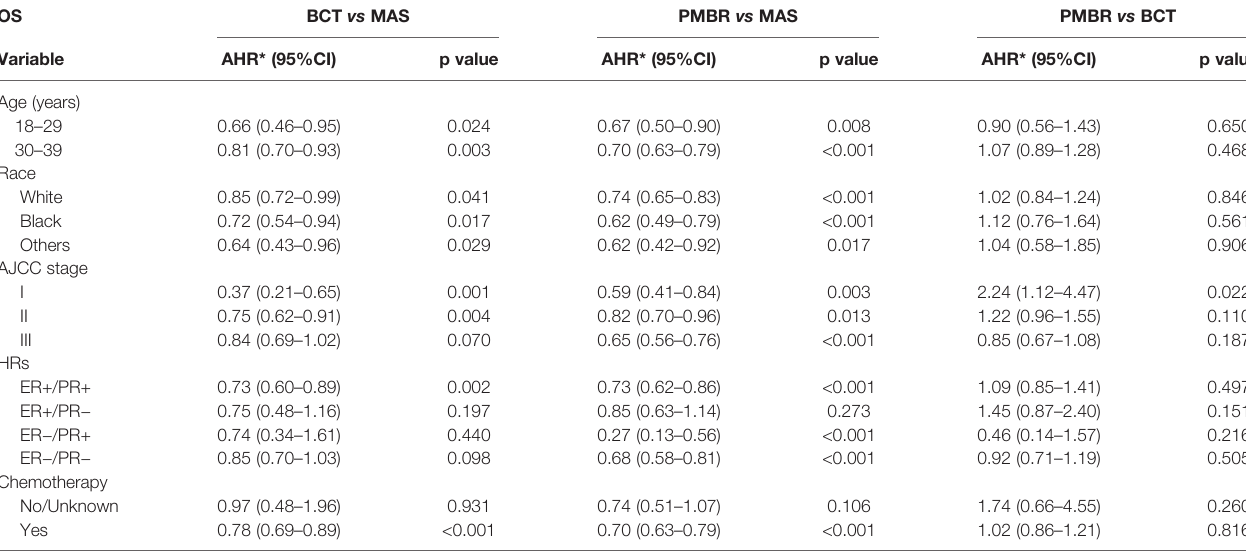
TABLE 2 | Effects of surgery in overall survival by demographic and pathological subgroups. OS BCT vs MAS PMBR vs MAS PMBR vs BCT Variable